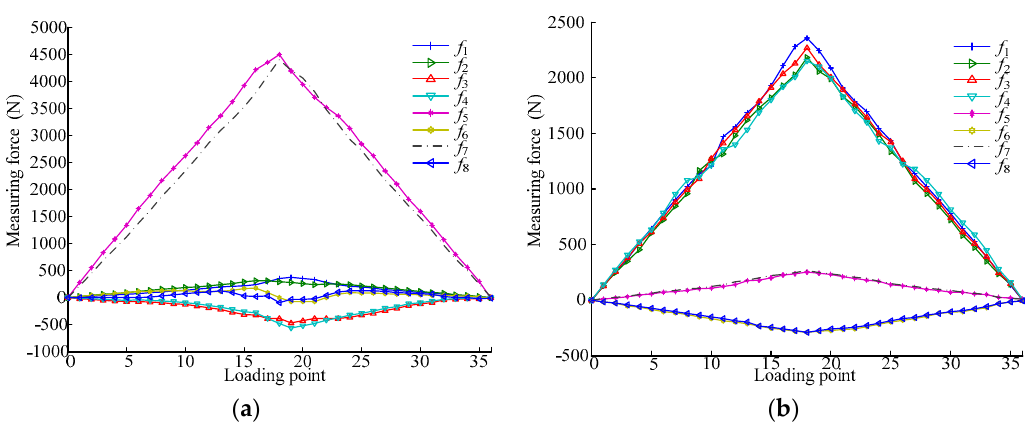
Figure 11. Output values of calibration experiment for load on the sensor under ( a ) F x and ( b ) F z .